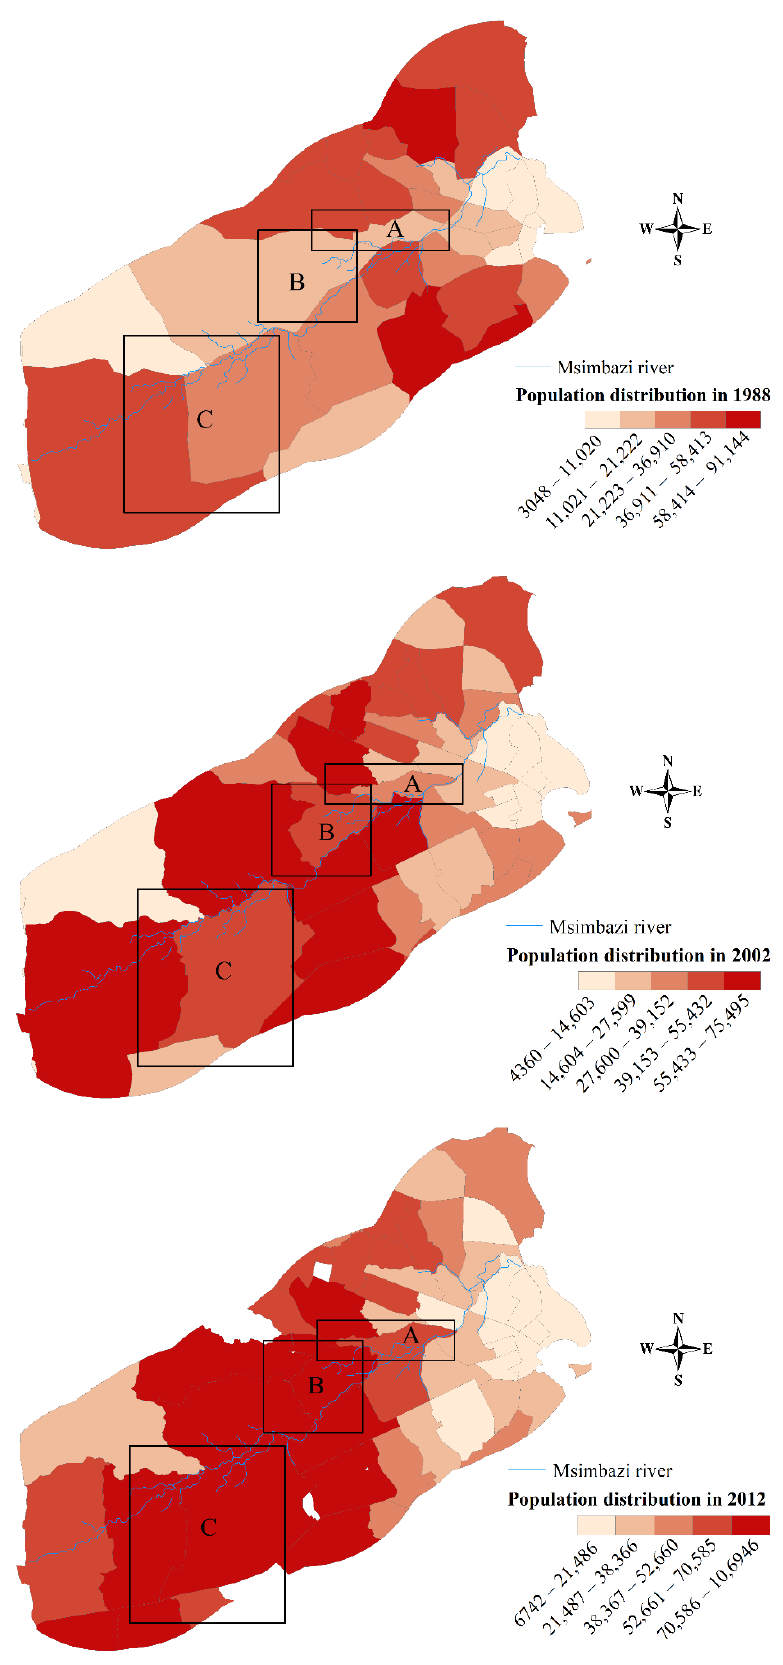
Figure 5. Population distribution maps by wards in 1988, 2002 and 2012.